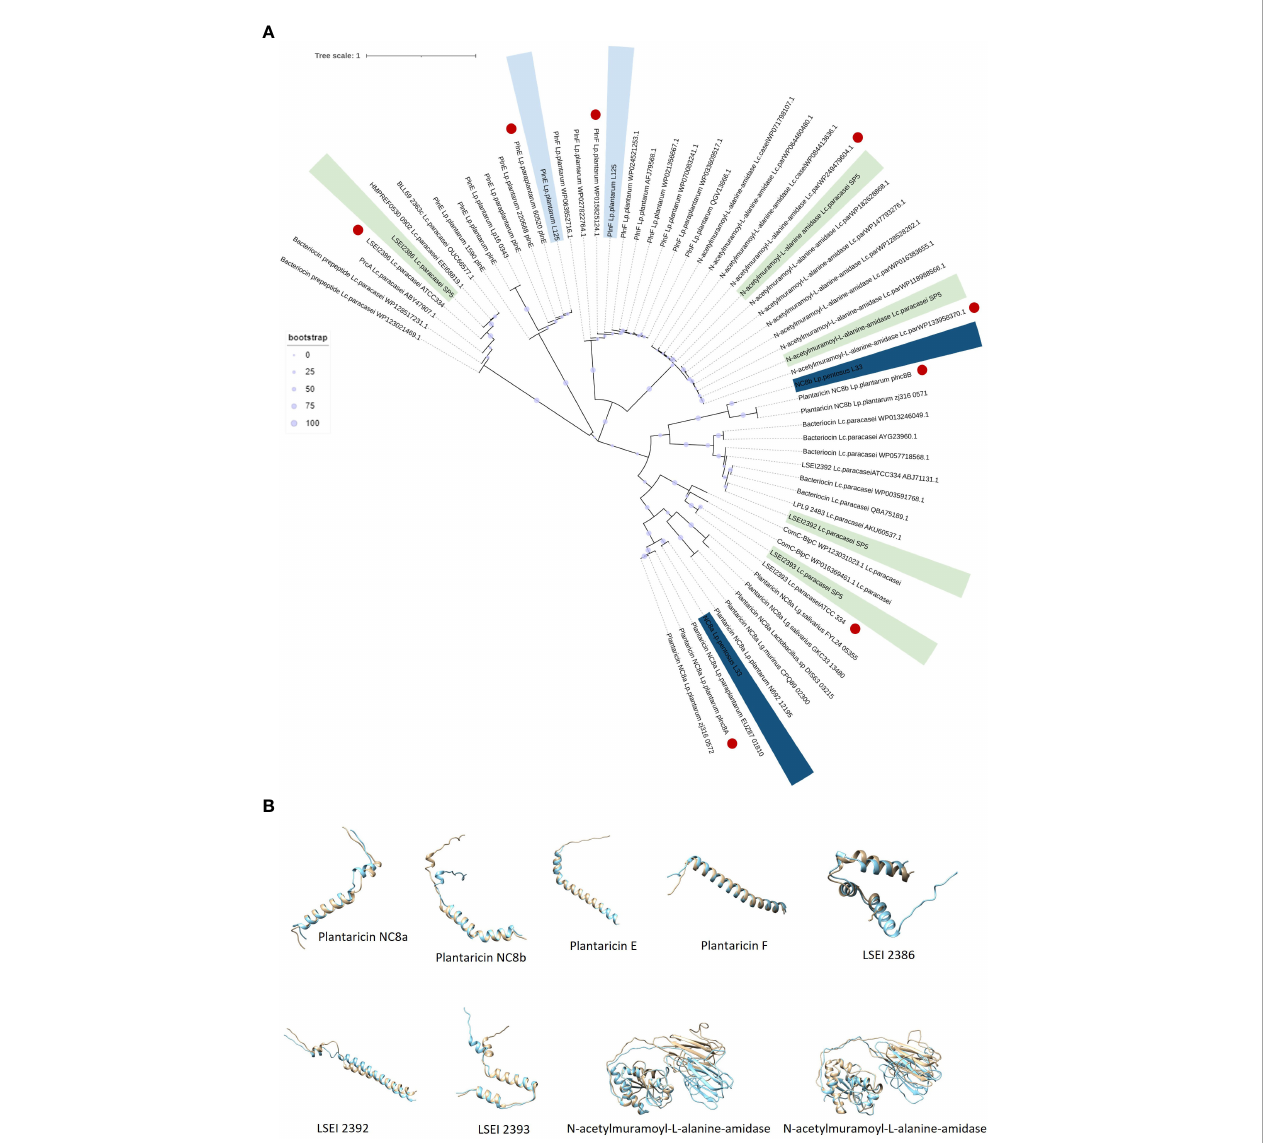
FIGURE 10 (A) Unrooted Neighbor-Joining tree containing putative bacteriocin sequences (pro-peptides) located in the whole genome sequence of the fi ve lactobacilli and homologous sequences of closely related LAB. Sequences with the highest sequence identity and structure conservation with the putative bacteriocins are denoted in red. (B) Structure superimposition of putative bacteriocins derived from the novel lactobacilli (blue) against functionally characterized peptides derived from the literature (light yellow). Structural predictions were made using ColabFold and structural superimpositions with Chimera